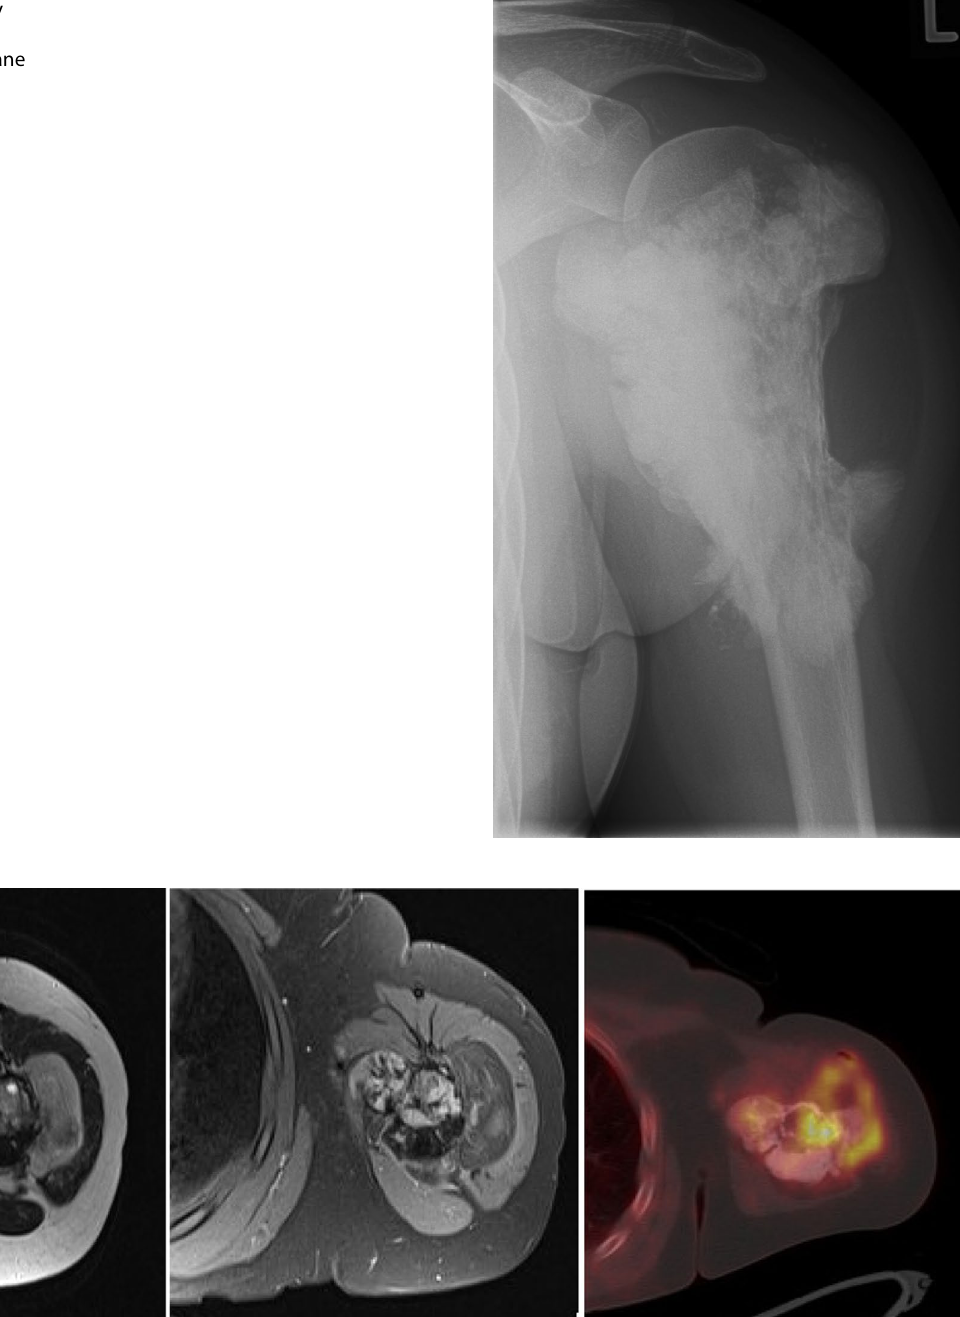
Fig. 1 Anterior–poste- rior radiograph of the left shoulder showing a densely osteoblastic mass encasing the humersu, a cleavage plane and a focal lucency lateral